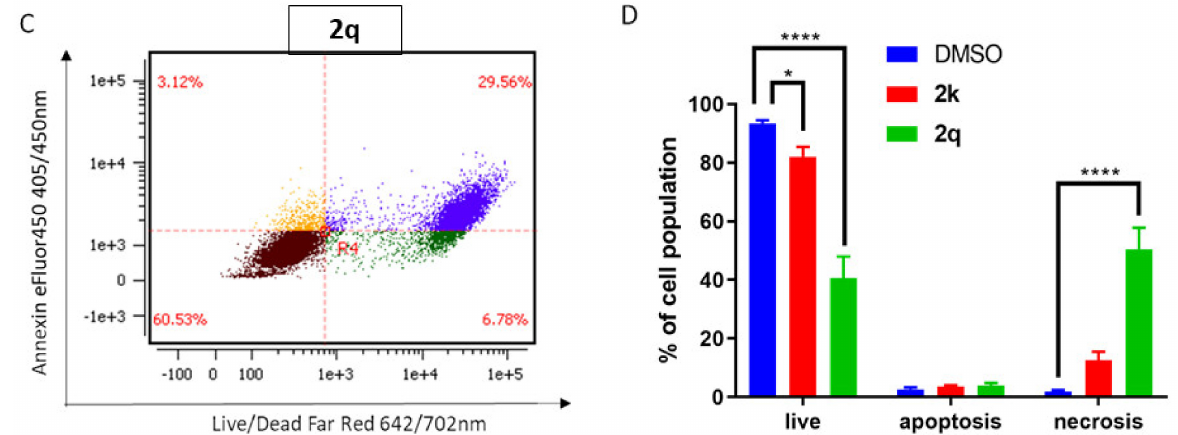
Figure 2. Cell death assay. Cells were treated by DMSO ( A ), 2q (0.5 µ M) ( B ), and 2k (1.0 µ M) ( C ) for 24 h. Representative dot plots of flow cytometry analysis after double staining of THP-1 cells by Annexin eFluor 450 and Live/Dead Far Red. Live cells ( Lower Left ), apoptosis ( Upper Left ) and necrosis ( Up Right ) were distinguished after. Average distribution of cell populations from three independent experiments-live, apoptotic and necrotic cells together with standard deviations, SE ( D ). * indicates statistical significance ( p < 0.05) between indicated groups, **** indicates statistical significance ( p < 0.0001) between indicated groups.